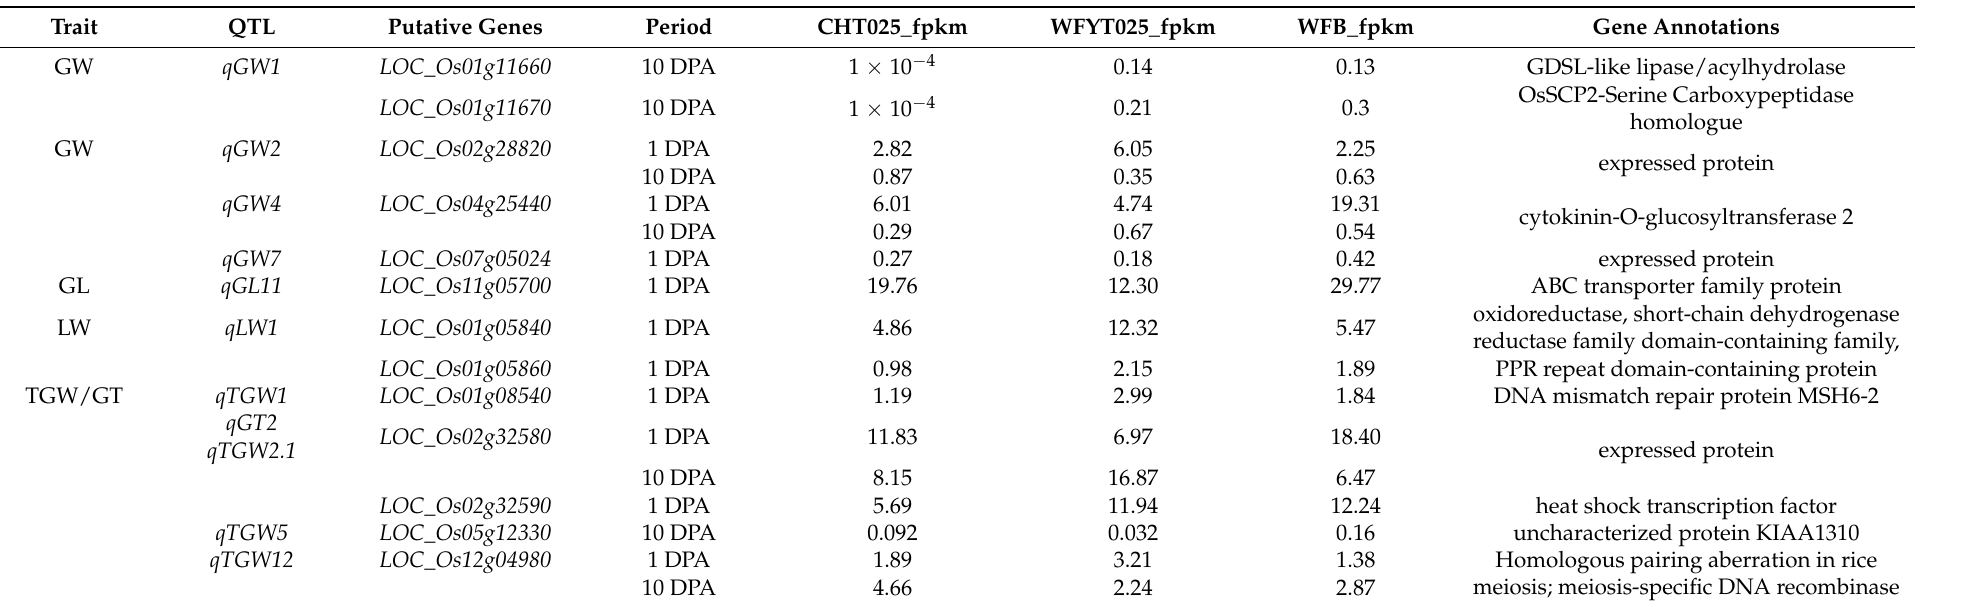
Table 4. Candidate genes are possibly involved in WFYT025 grain weight heterosis using QTL mapping and